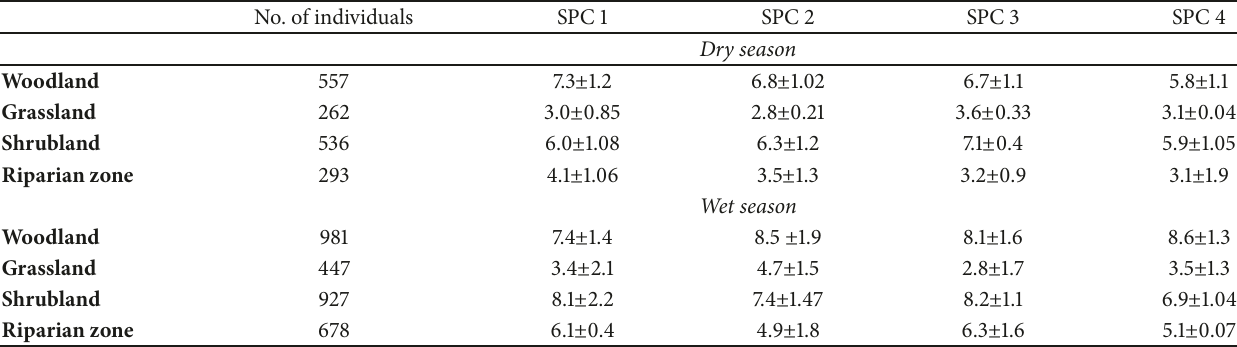
Table 1: Mean number of birds counted at each sampling point count (SPC), across the four habitat types, in the wet ( n = 3033) and dry ( n = 1648) seasons.